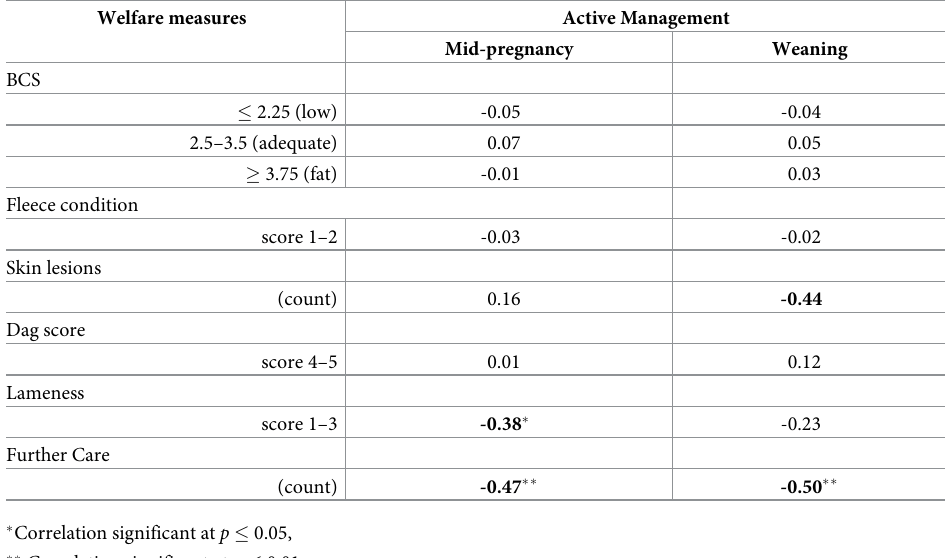
Table 2. Spearman’s rank correlations between management and welfare